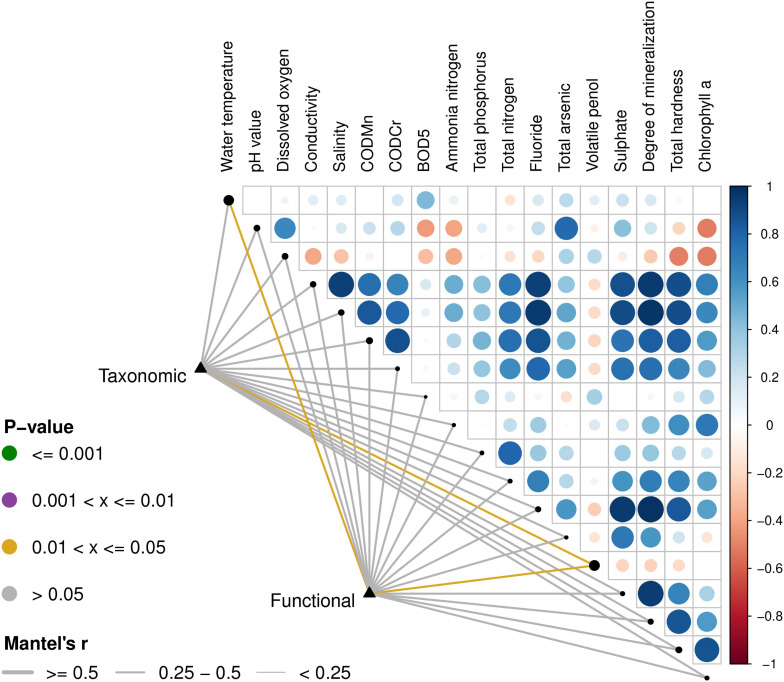
Environmental drivers of microbial community compositions in water. The distance correlation of the Mantel r statistics in the lower left corner corresponds to the line width, and the statistically significant P value corresponds to the line color. The upper right triangle is a display of the calculation for the Pearson correlation coefficient (PCC) between each physical and chemical factor, the circle color indicates the correlation coefficient on the corresponding color axis, and the circle size indicates the absolute value of the corresponding correlation coefficient. Therefore, the darker the color, the greater the correlation, the lighter the color, the weaker the correlation. The corresponding longitudinal circles of each environmental factor correspond to the pairwise correlations of the environmental factors arranged from far to near on the left side, respectively. The size of the black dots on the diagonal represents the size of the addition of the species composition data and the functional composition data of the Mantel’s r-statistics.